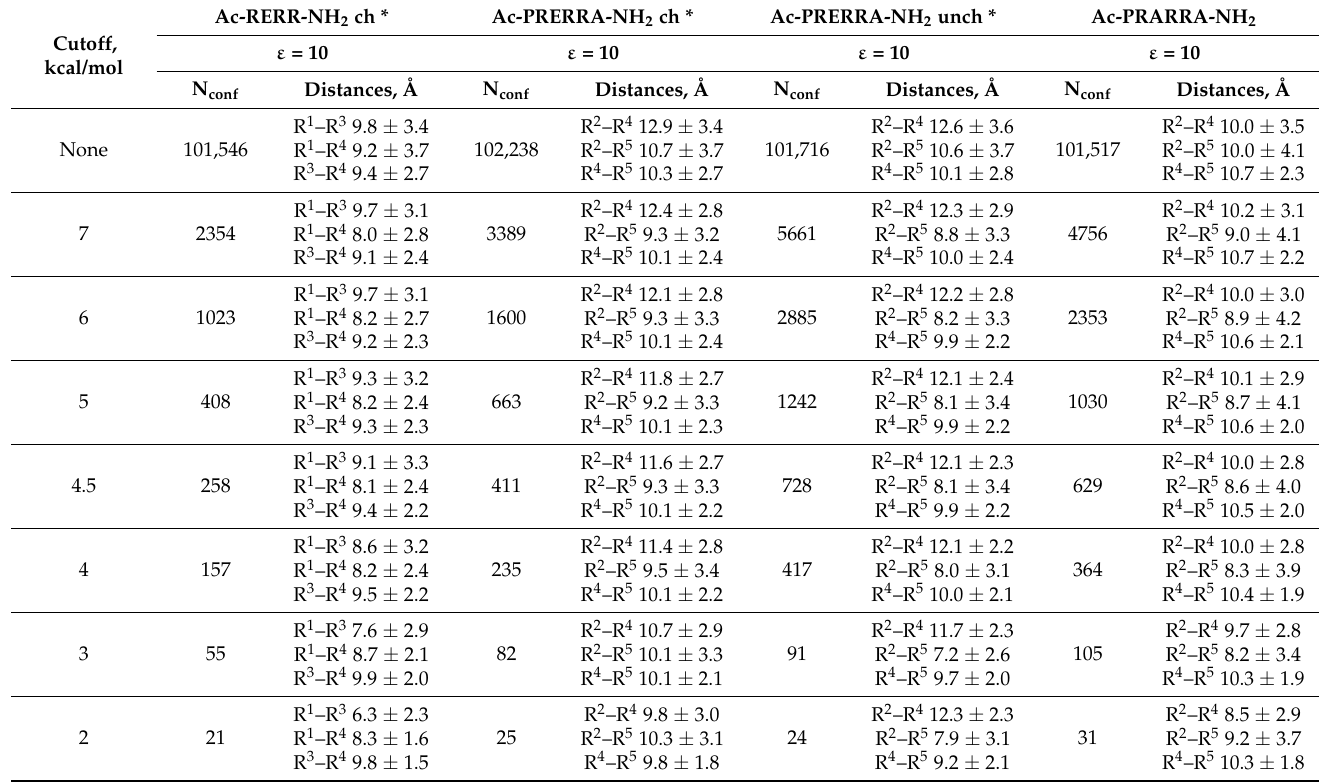
Table 2. Average distances between the guanidinium groups in the molecules of arginine-containing short peptides containing three arginine